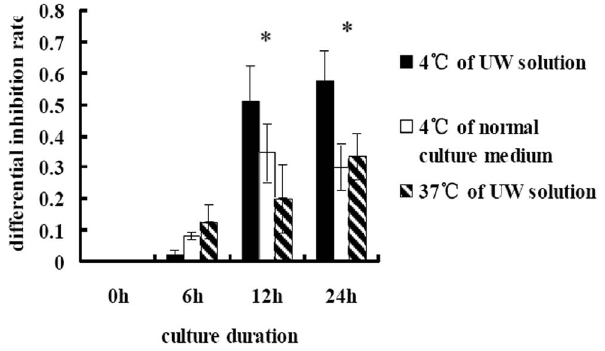
Figure 2. The differential inhibition of proliferation between HK-2 and 7860 cells in differing culture conditions. The differential inhibition rate is the difference between inhibition rate of proliferation of 7860 and HK-2 cells by different culture conditions.